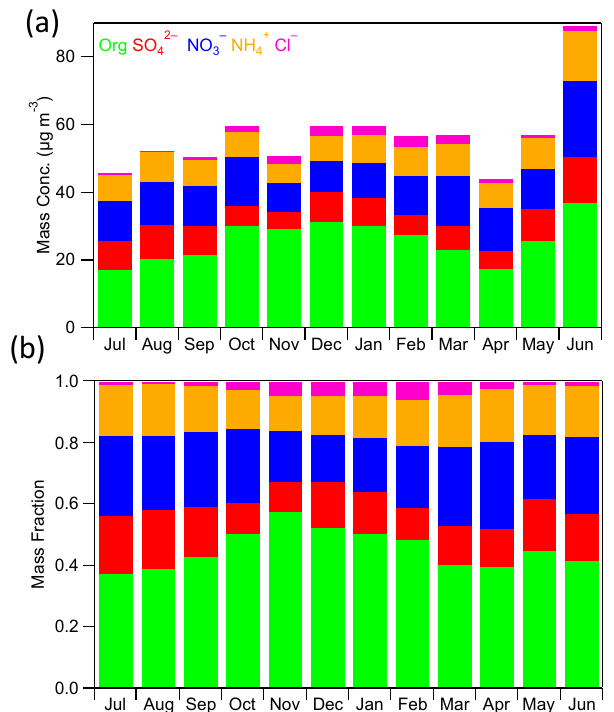
Figure 6. Monthly variation of (a) mass concentrations and (b) mass fractions of NR-PM 1